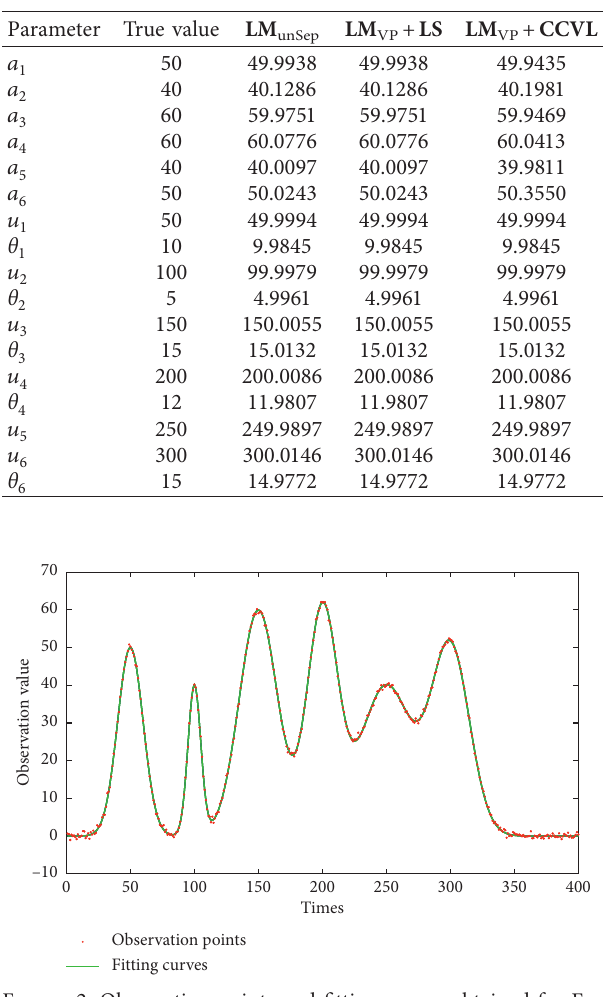
Figure 2: Observation points and fitting curves obtained for Ex- ample 1 for the three methods.